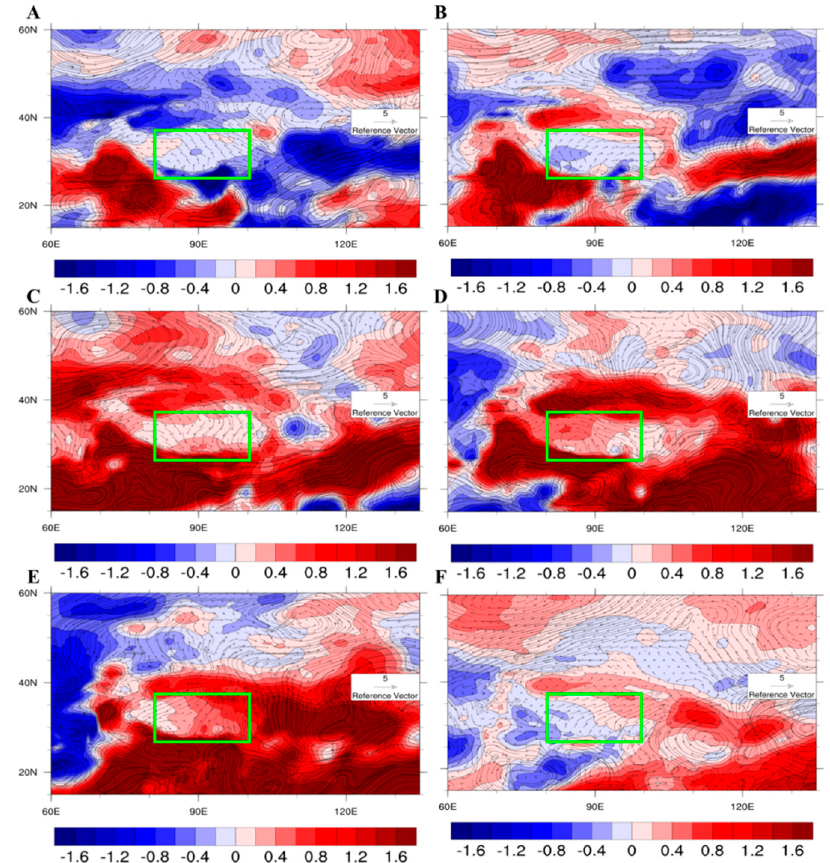
Figure 9. Anomaly distributions of the water vapor and its flux over the TP and its surrounding regions in 2014 ( A ), 2015 ( B ), 2016 ( C ), 2017 ( D ), and 2018 ( E ) and composite analysis of the water vapor relative to the years with rapid increases and decreases of precipitation ( F ).The black arrows represent the transport of water vapor by the horizontal movement of the atmosphere. The green rectangular boxes represent the location of the